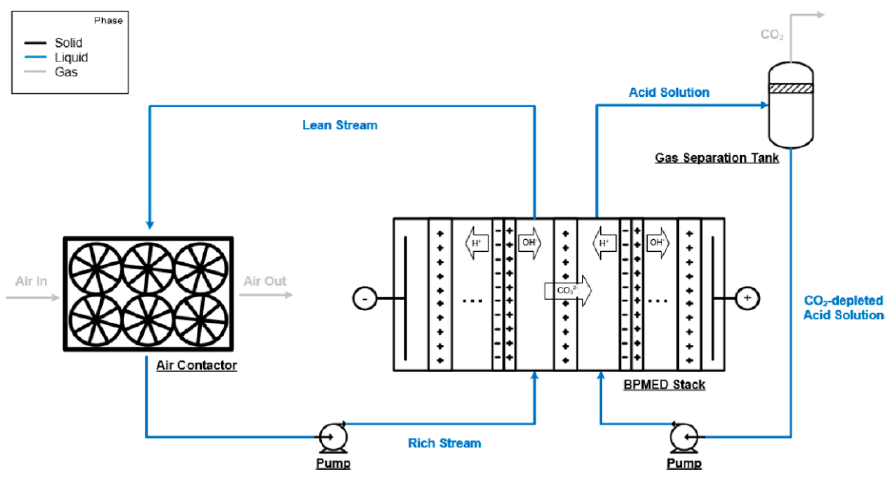
Figure 11. Process scheme for CO 2 capture from the air using bipolar membrane electrodialysis.